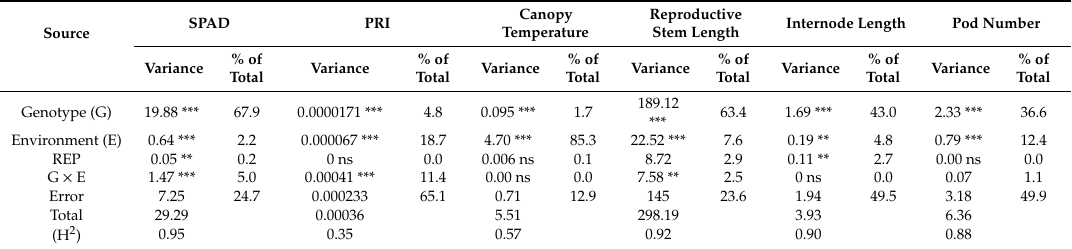
Table 2. Variance components of environment, genotype, and their interaction and broad sense heritability (H 2 ) on SPAD, PRI, canopy temperature, reproductive stem length, internode length and pod number in 135 pea accessions.